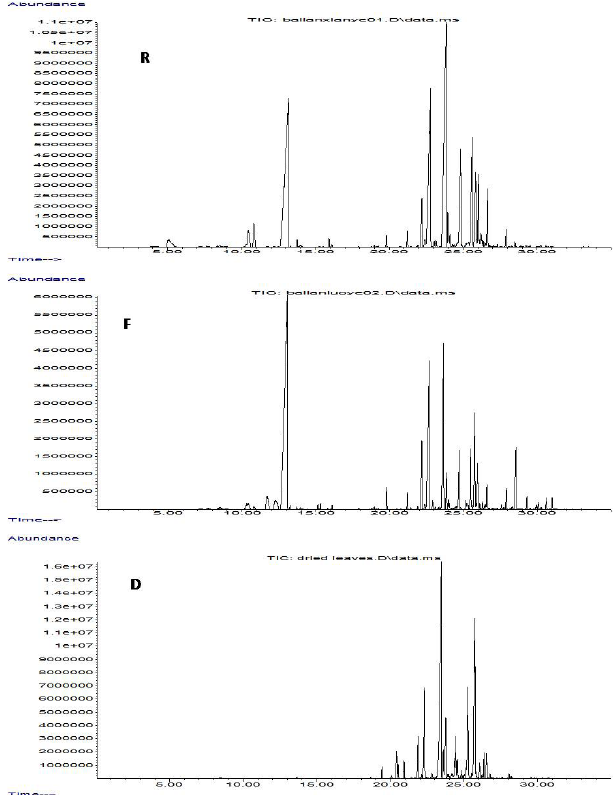
Fig 4 . GC-MS total ion chromatograms of mashed fresh (R), fallen (F), and dried (D) leaves of M.